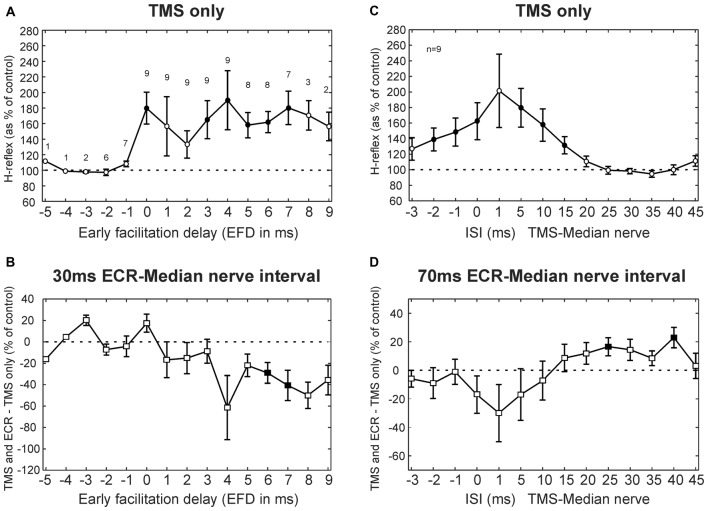
TMS results averaged across subjects. (A) Effects of TMS on the FCR H-reflex at different early facilitation delays (EFD). Numbers above each result display the number of subjects contributing to each data point. (B) Difference between the effect of TMS on the H reflex, and the effect of TMS on the H reflex conditioned by ECR stimulation 30 ms before the median nerve shock. Numbers of subjects contributing at each interval are as in (A). (C) Effects of TMS on the FCR H-reflex at different ISIs. (D) Difference between effect of TMS on H reflex, and on H reflex conditioned by ECR stimulation 70 ms before the median nerve shock. Filled symbols show responses significantly different from 100% (A,C) or 0% (B,D). Error bars indicate standard error of the mean. (C,D) are both averaged over n = 9 subjects.